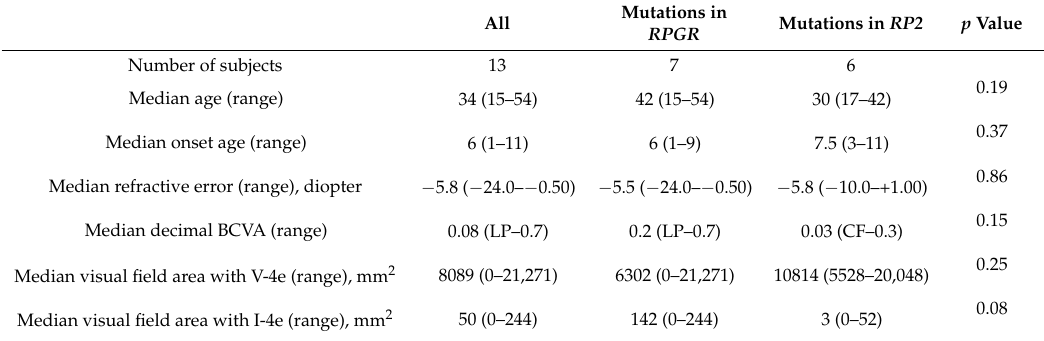
Table 2. Summary of the clinical characteristics of affected male subjects in the present study. All